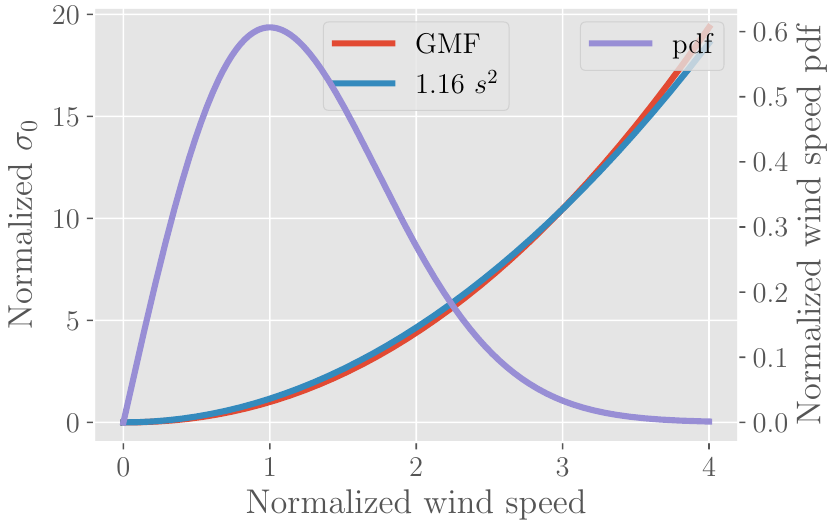
Figure 2. Ka-band σ 0 (not in dB) averaged over all azimuth angles divided by σ 0 ML ( 22dB), the cross section of the most likely wind speed value, v ML = 5.9m/s, as a function of the ∼− wind speed divided by v ML . (Red line) Data from [13]; (Blue line) Quadratic fit. (Purple line) Rayleigh distribution of normalized wind